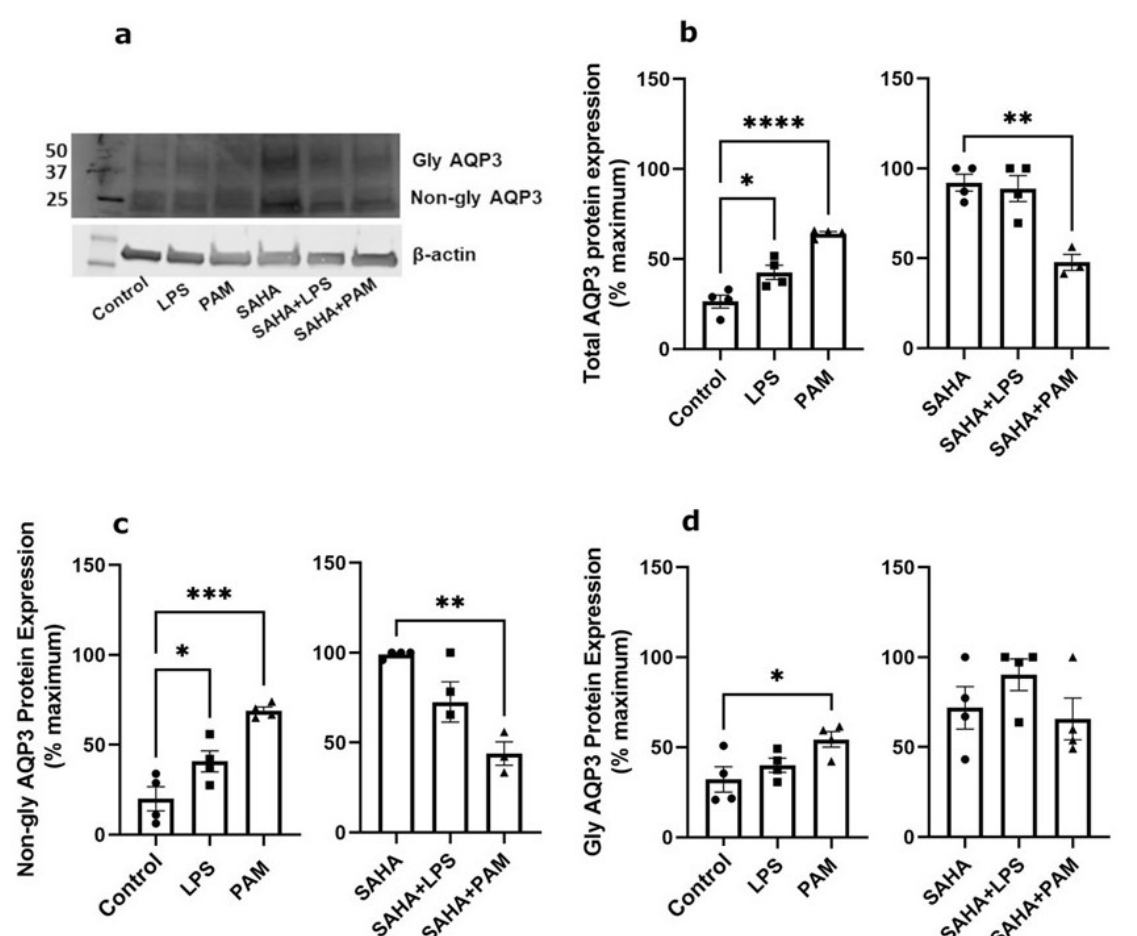
Figure 3. TLR2/TLR4 Activation Increased AQP3 Protein Expression Basally and TLR2 Reduced SAHA-induced AQP3 Levels. Mouse keratinocytes were treated with 0 and 2.0 µg/mL LPS or 2.5 µg/mL PAM, in the presence or absence of 1 µM SAHA, for 24 h. Cells were lysed in 3% boiling SDS lysis buffer and processed for Western analysis. ( a ) Representative Western blot showing APQ3 protein expression. ( b ) Left panel: total AQP3 protein expression in the absence of SAHA. Right panel: total AQP3 protein expression in the presence of SAHA. ( c ) Left panel: non-glycosylated AQP3 protein expression in the absence of SAHA. Right panel: non-glycosylated AQP3 protein expression in the presence of SAHA. ( d ) Left panel: glycosylated AQP3 protein expression in the absence of SAHA. Right panel: glycosylated AQP3 protein expression in the presence of SAHA. The data are expressed as % maximal response among all six groups, with the values in the absence and presence of SAHA analyzed separately and representing the means ± SEM from 3 to 4 independent experiments; symbols represent individual experiments. Note that one data point corresponding to the PAM treatment in the presence of SAHA from the total AQP3 protein expression (( b ), right panel) and one from the non-glycosylated AQP3 protein expression (( c ), right panel) were identified as significant outliers ( p < 0.05) by the GraphPad Outlier Calculator and were removed from the statistical analysis. * p < 0.05, ** p < 0.01, *** p < 0.001, **** p < 0.0001 versus the control value. 2.3. AGE-BSA from BioVision, Inc. Was Not Contaminated with TLR-Activating Endotoxin The datasheet provided by BioVision, Inc., (Waltham, MA, USA) for their AGE-BSA indicates endotoxin contamination of less than 0.1 IU/mg protein. To determine whether uncontaminated AGEs can serve as TLR-activating DAMPs, the HEK-Blue TLR4 reporter cell line was incubated with various doses of AGE-BSA from BioVision, Inc. Concentrations of AGEs ranging from 10 to 50 µ g/mL showed no activation of TLR4 compared to the phosphate-buffered saline (PBS) control. Even at a concentration of 100 µ g/mL, AGEs